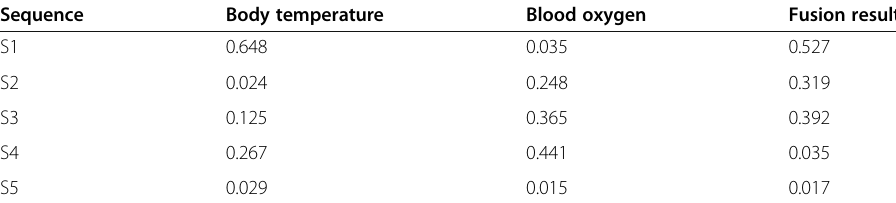
Table 1 Fusion results of body temperature and blood oxygen Sequence Body temperature Blood oxygen Fusion result